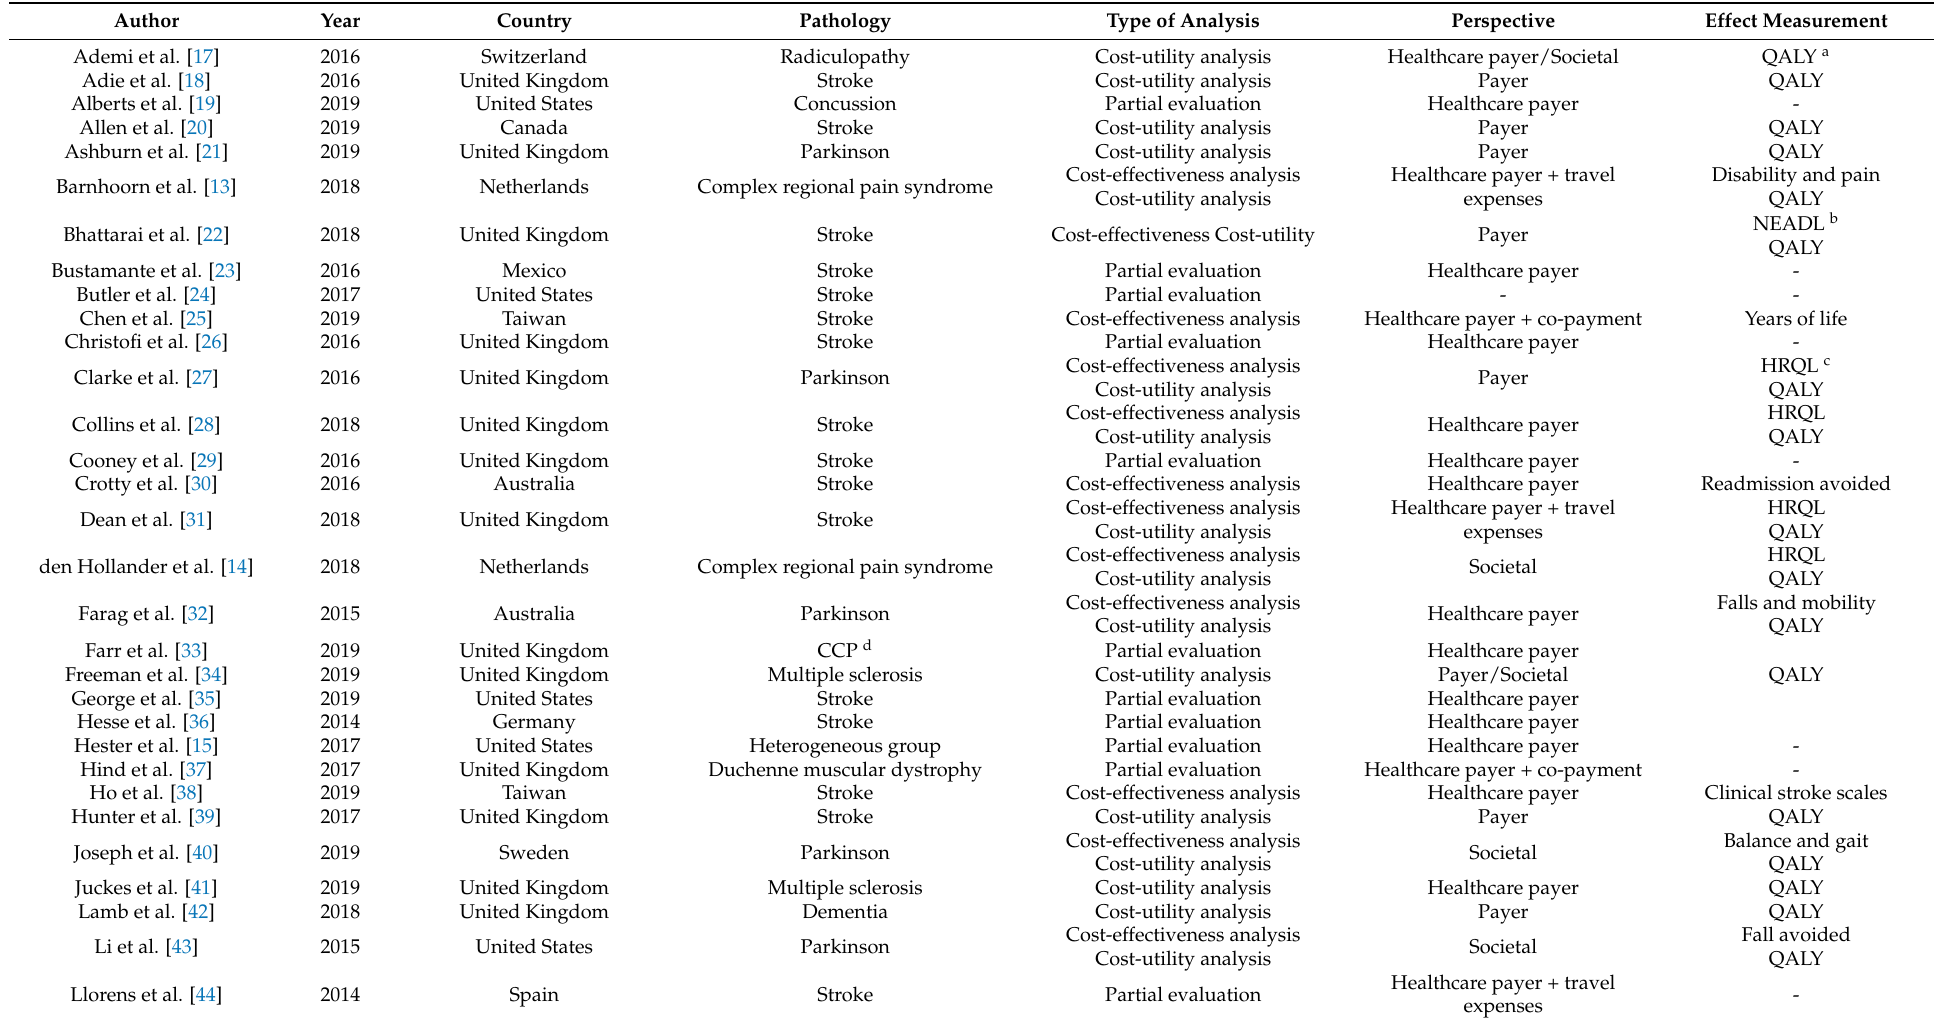
Table 1. Characteristics of the studies included in the systematic